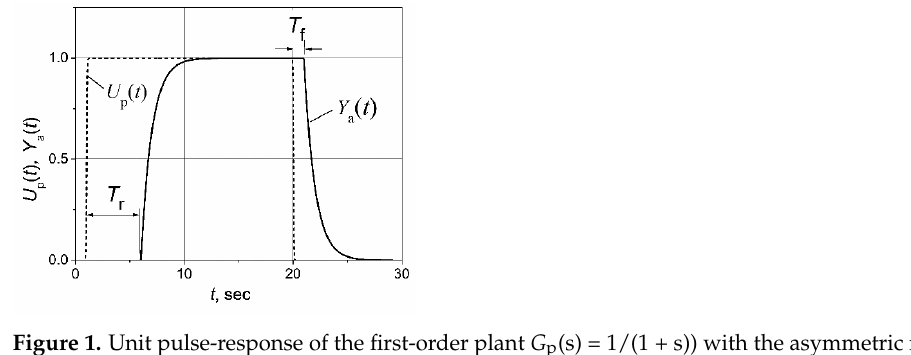
Figure 1. Unit pulse-response of the first-order plant G p (s) = 1/(1 + s)) with the asymmetric response delay to the rising-and-falling plant-control signal U p ( t ). T r = 5 s, T f = 1 s. Y a ( t ) is the plant’s output parameter.